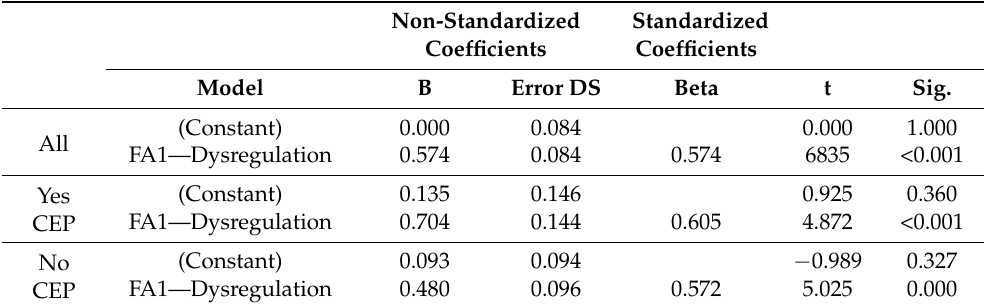
Table 12. Regression analysis on extracted factors to predict the level of smartphone problematic